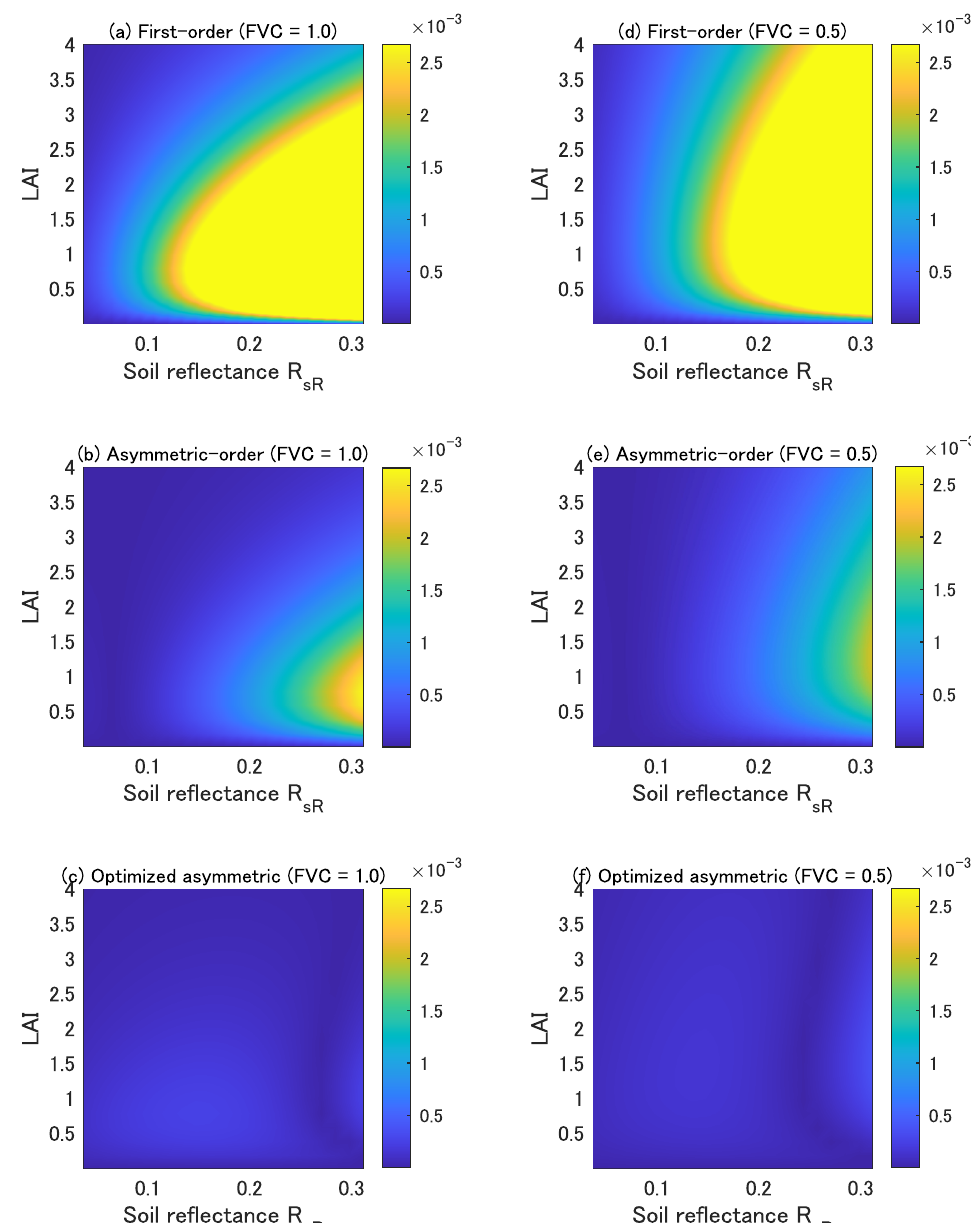
Figure 1. Errors in the first-order isoline equation (upper panels, ( a , d )), asymmetric-order isoline equation (middle panels, ( b , e )), and optimized asymmetric-order isoline equation (bottom panels, ( c , f )) for red and NIR wavelength pairs as a function of the LAI and soil reflectance. The FVC is 1.0 for the left panels ( a – c ) and 0.5 for the right panels ( d – f